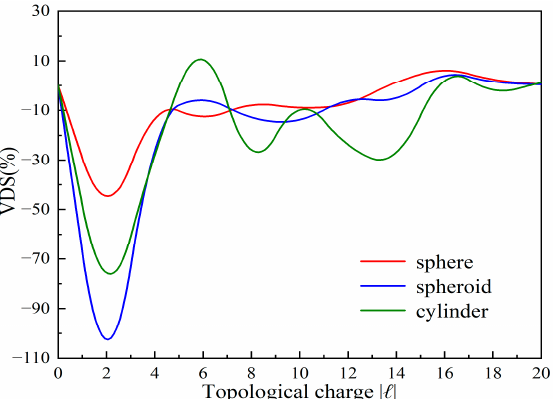
Figure 7. Comparison of the VDS spectra from dielectric chiral sphere, spheroid, and cylinder.